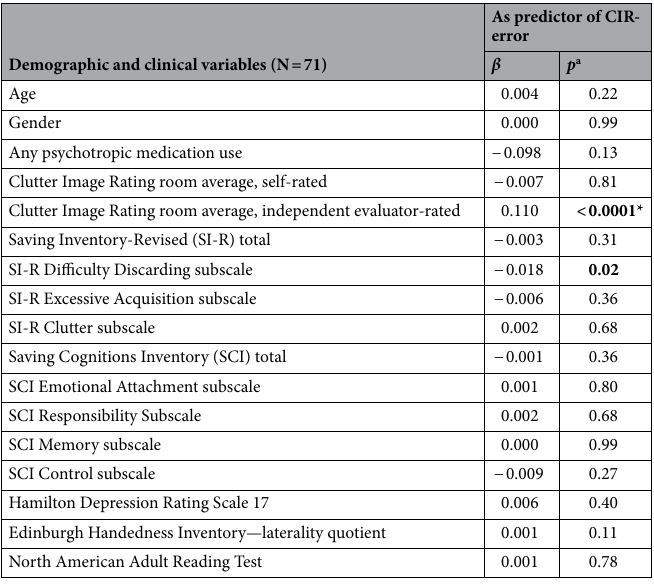
Table 2. Demographic and clinical variables as predictors of clutter underreporting (CIR-error). a p values < 0.05 are indicated in bold text. *Meets Bonferroni-corrected alpha threshold of p <